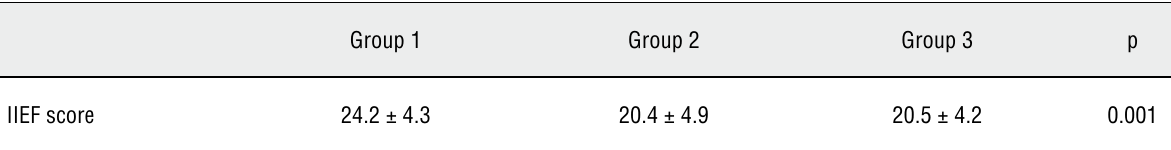
Table 3 - IIEF scores relative to the groups.